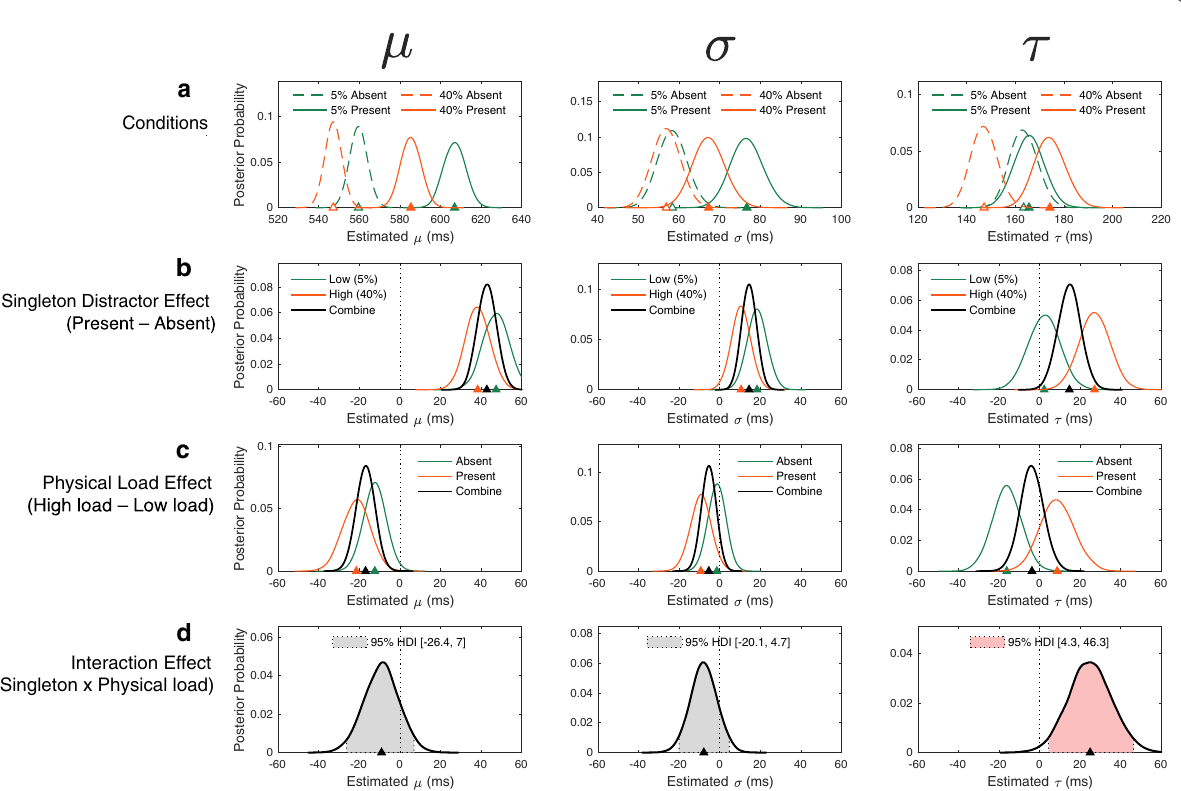
Fig. 3 Posterior distributions of the hierarchical Bayesian ex‑Gaussian parameters. The curves indicate the fits of a nonparametric kernel density estimates to the posterior samples for each group‑level parameter. The triangles on the x‑axis indicate posterior means. The posterior distributions of each parameter across all four conditions ( a ) can be decomposed into the main effect of singleton distractor presence versus absence ( b ), physical load ( d ), and the interaction effect ( d ). For the interaction effect ( d ), shaded areas represent 95% highest density interval (95% HDI) of posteriors. Only the exponential parameter τ yielded a credible interaction effect with the lower bound not crossing zero